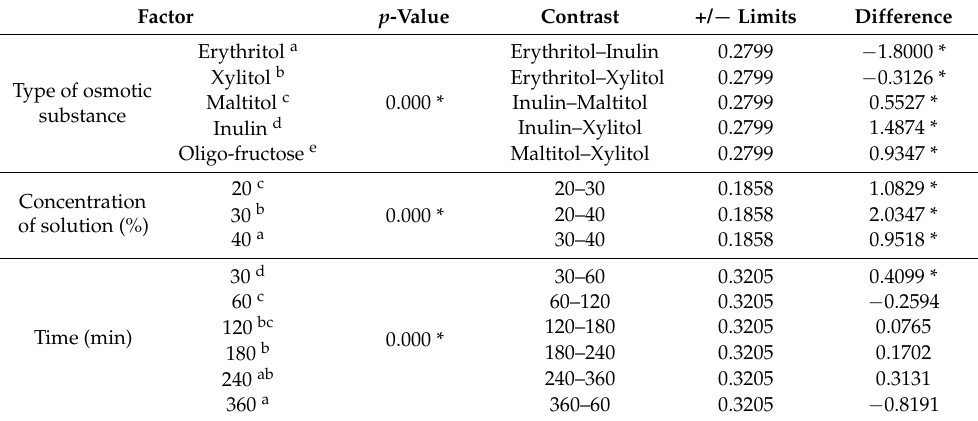
Table 3. The influence of osmotic pre-treatment in different solution types, concentrations, and times, on the water content (g/g d.m.) in fruits.